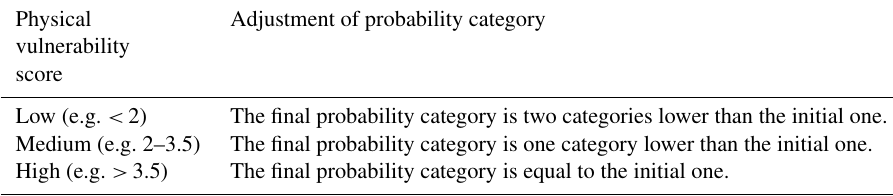
Table 6. Indicative criteria for determining the probability category using vulnerability indicators and adaptation of initial categorisation to final